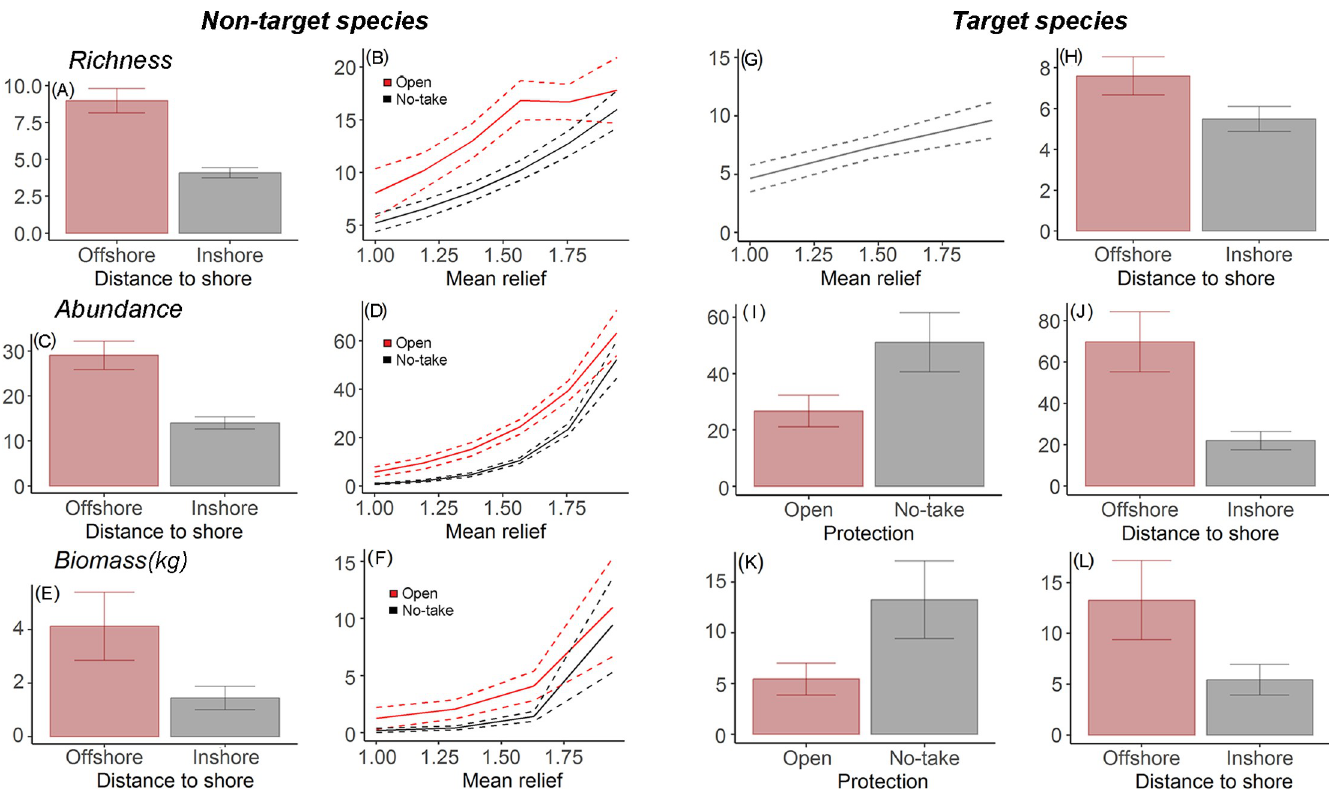
Fig 4. Plots of the most parsimonious models for target and non-target fish assemblage overall characteristics, with > 10% variance explained shown. On-target species (A,B) richness, (C,D) abundance, (E,F) biomass. And for target species (G,H) richness, (I,J) abundance, (K,L) biomass. The dotted line represents 95% confidence